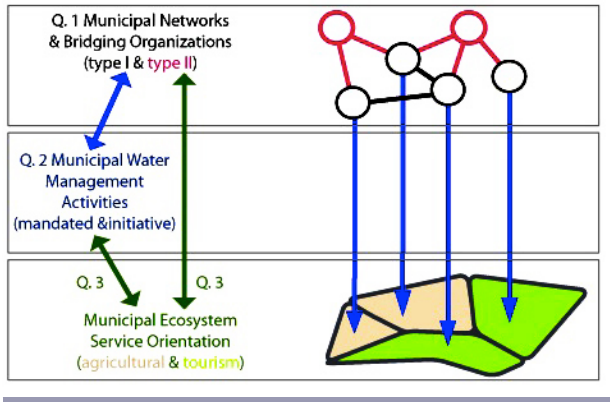
Fig. 1 . Our research analyzes a social-ecological landscape by examining how direct (black) and indirect (purple) social networks among municipalities are related to municipal water management activities, and the agricultural or tourism oriented use of ecosystem services within each